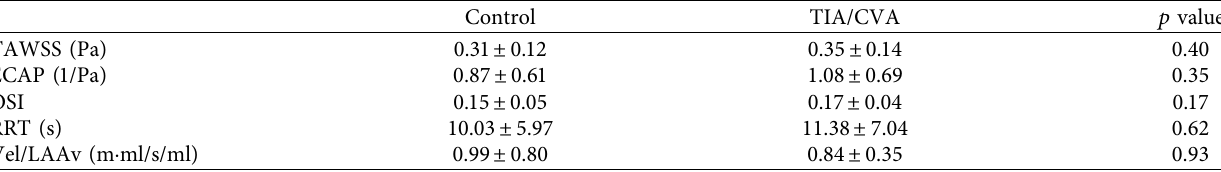
Table 4: Haemodynamic indices (mean ± standard deviation) for the whole LAA and each region for chicken-wing (CW) and non-chicken- wing (Non-CW) LAA shapes.